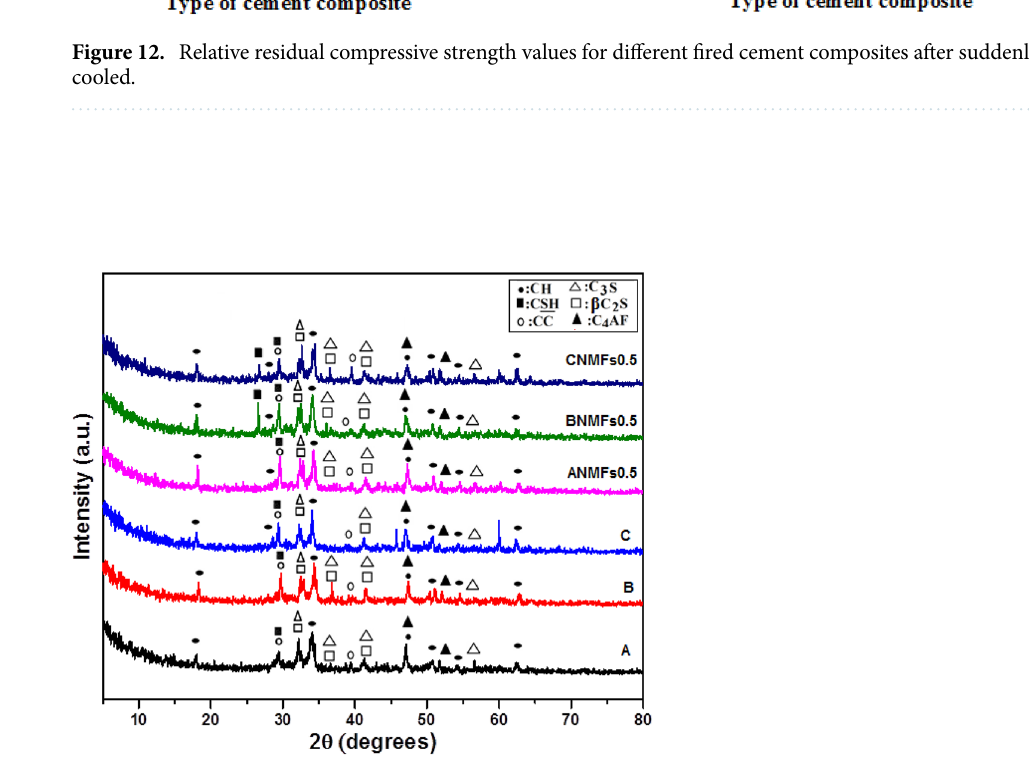
Figure 13. XRD patterns of hardened composites made from mixes ( a – c ), and nanocomposites made from mixes (ANMFs0.5–CNMFs0.5) at 7 days of